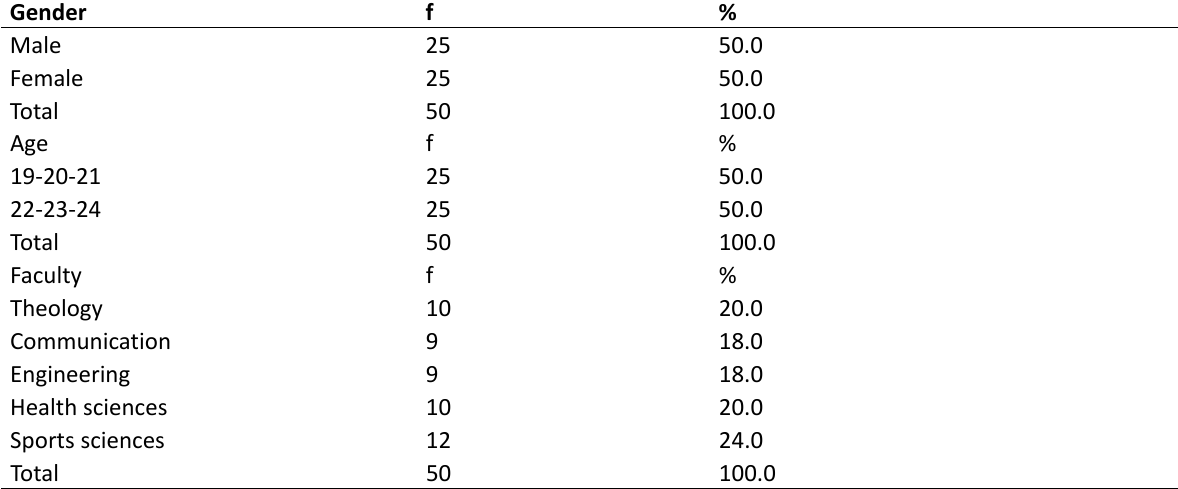
Table 1. The personal information of the